Question: According to this chart, does the measure grow or shrink?
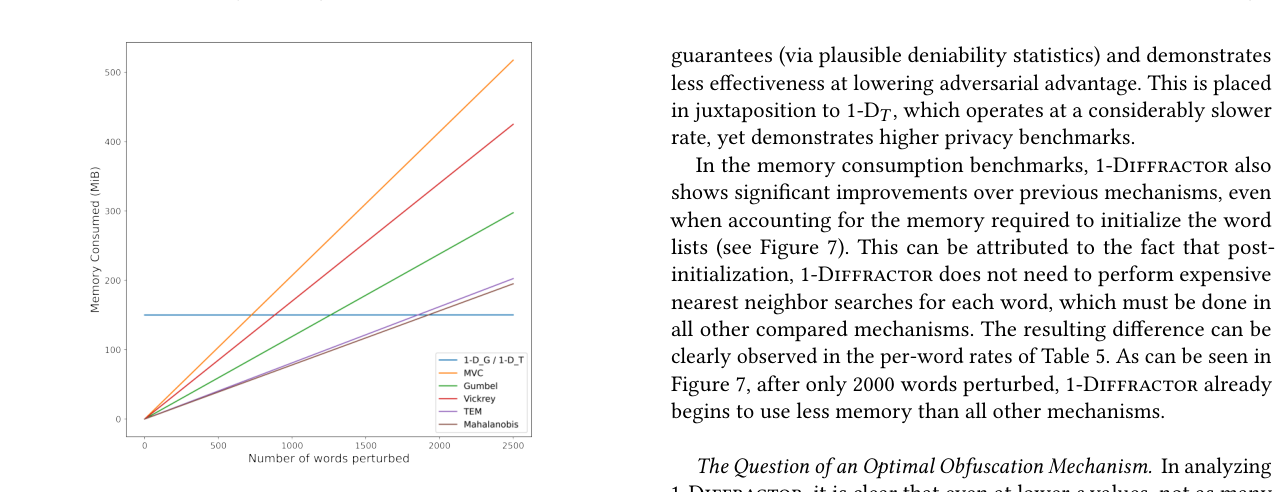
Answer: increasing